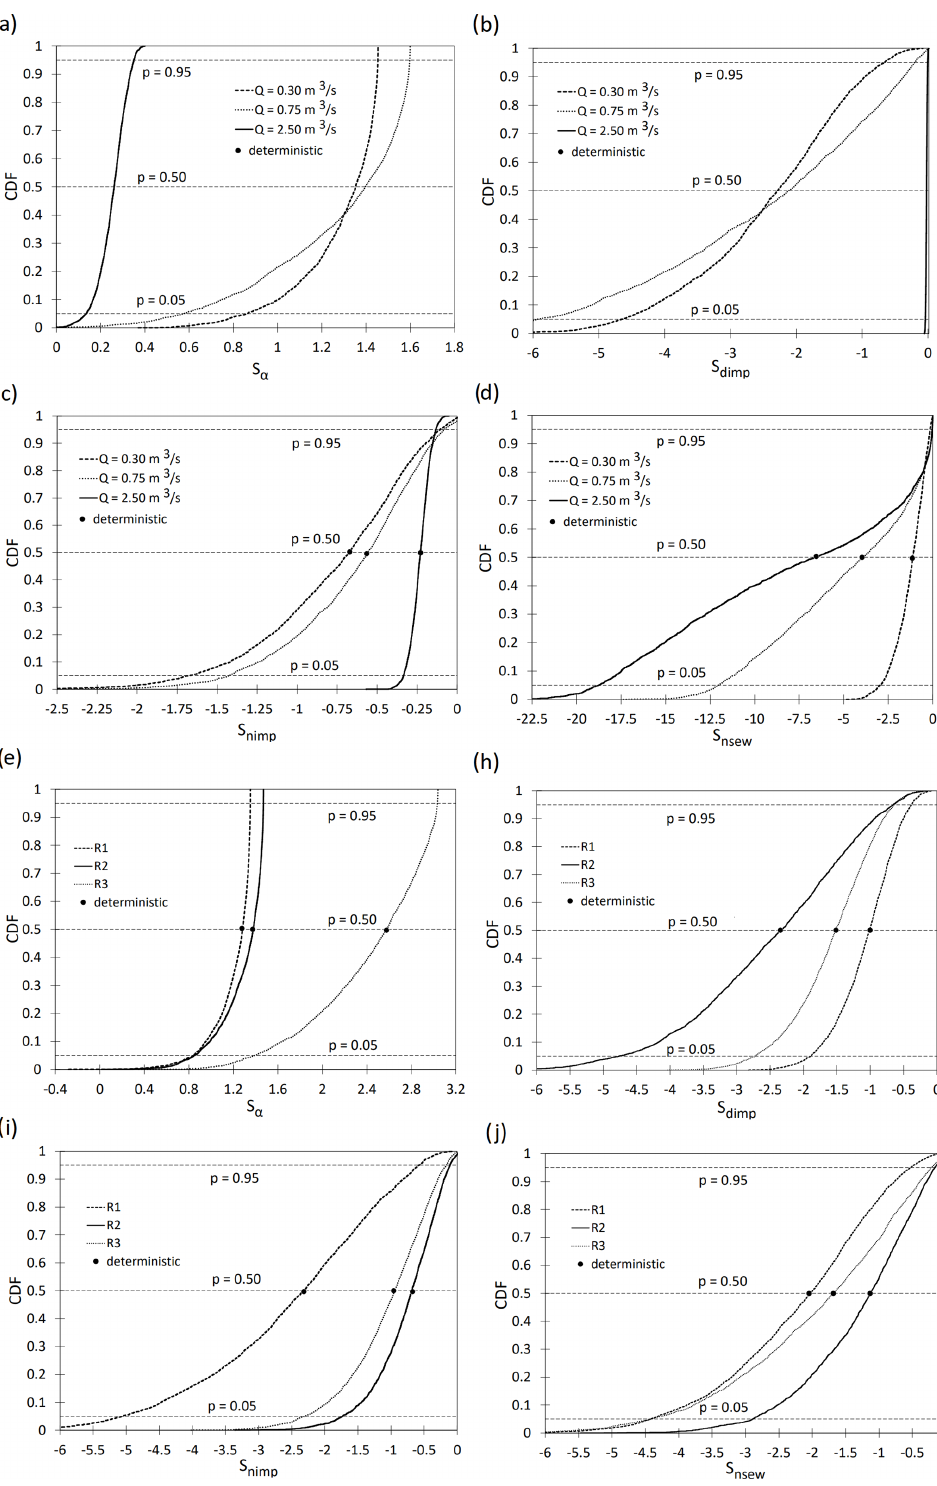
Figure 4. Comparison of the calculated results (deterministic and probabilistic solutions) of sensitivity coefficients ( S α , S dimp , S nimp , and S nsew ) for (a–d) threshold values ( Q = Q g , m ) and temporal rainfall distribution ξ = R2 and (e–h) temporal rainfall distributions ( ξ = R1, R2, and R3) for Q g , m = 0.30m 3 s − 1